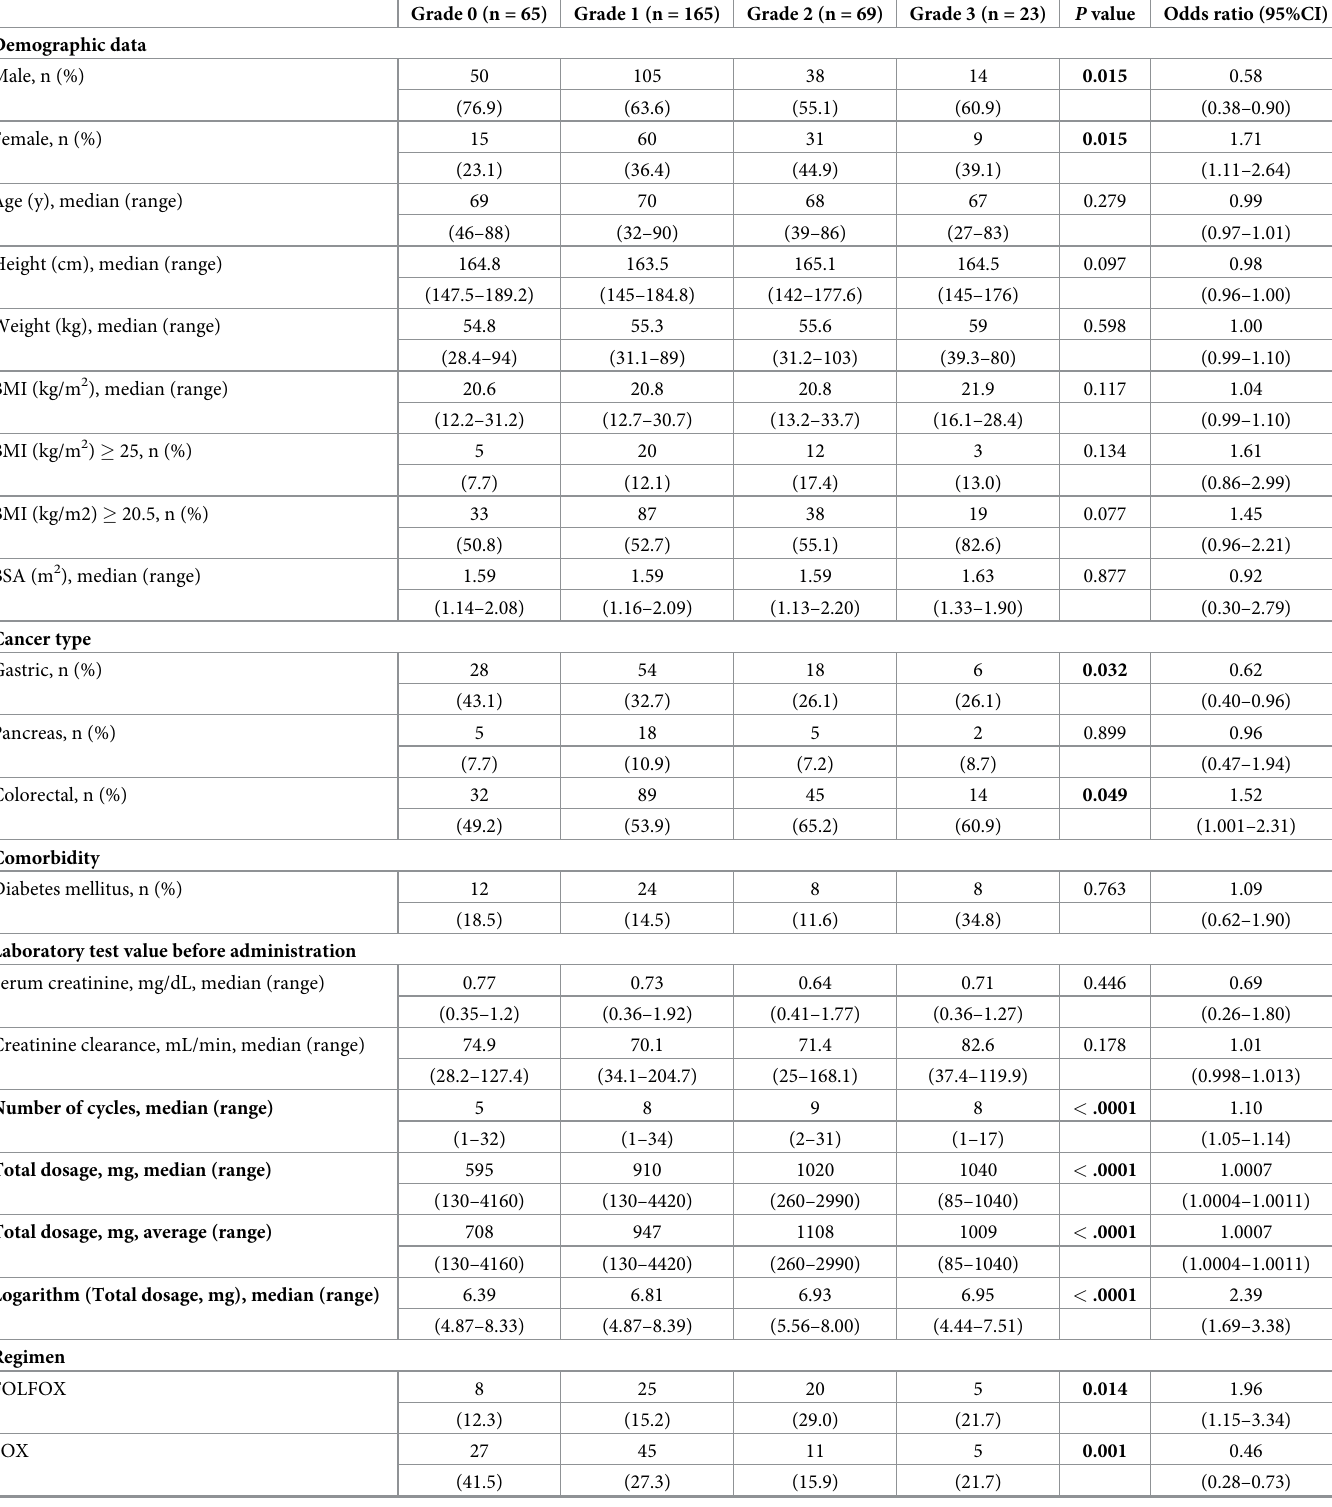
Table 1. Patient characteristics, extracted variables, and results of univariate analyses (n =